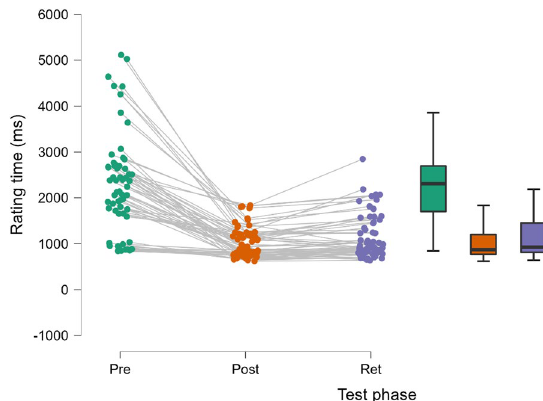
Fig. 8 Individual average rating times are shown at pre‑training (pre, green), post‑training (post, orange), and retention (ret, purple) testing phases, as connected dot‑clouds per participant‑image type combination and boxplots to show both individual patterns and the population distributions